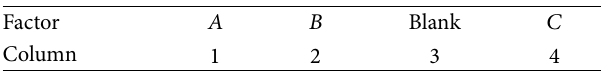
Table 3: Header design for the orthogonal